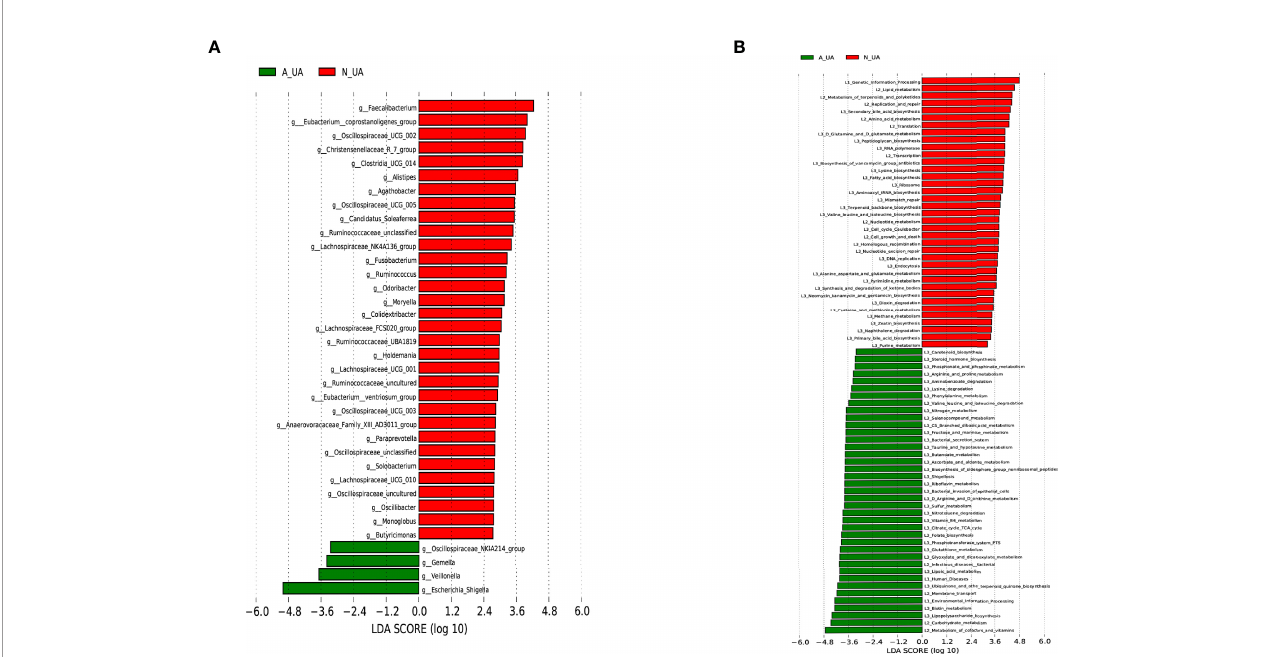
FIGURE 7 | Linear discriminant analysis (LDA) effect size (LEfSe) analysis of microbial pro fi les and metabolic pathways. (A) LEfSe analysis of microbial pro fi les between N_UA and A_UA at the genus levels. (B) LEfSe analysis showing different metabolic pathways between N_UA and A_UA. N_UA, normal uric acid; A_UA, abnormal uric